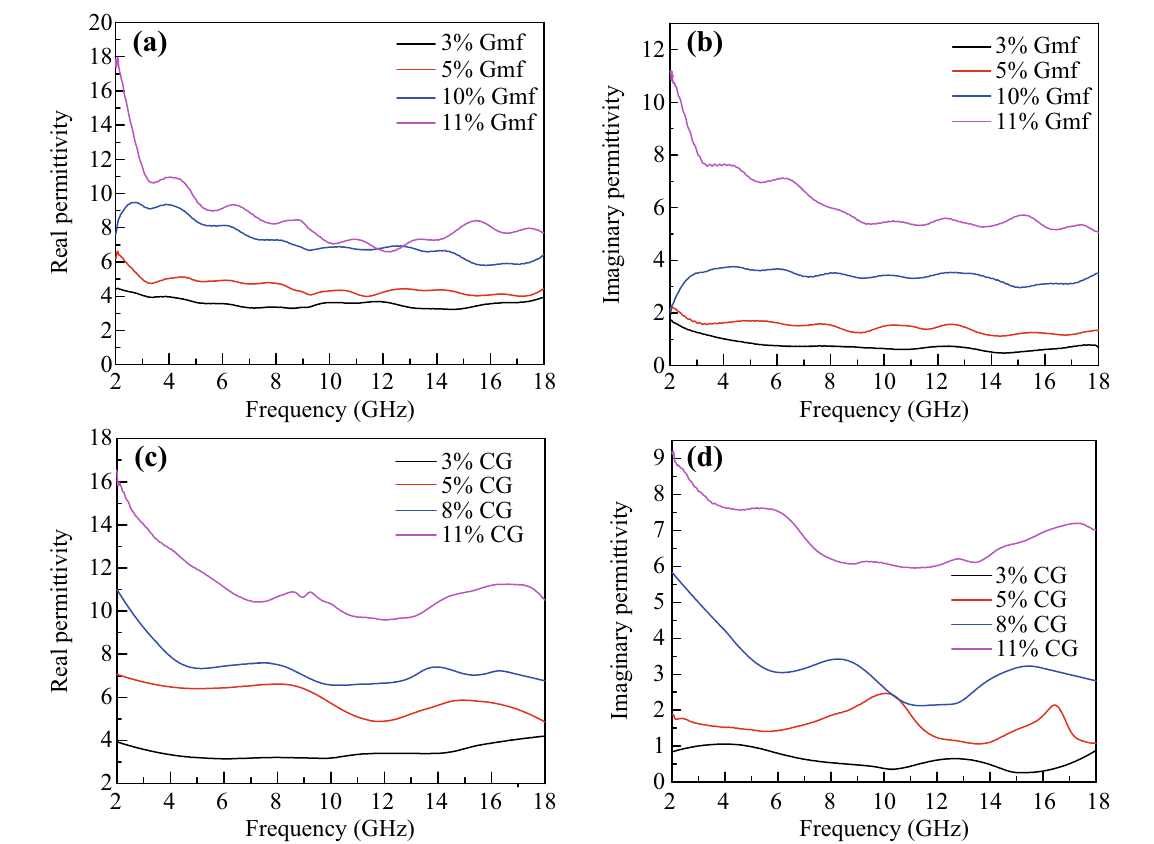
Fig. 3 a The real parts and b imaginary parts of permittivity of Gmfs/paraffin composites with different filler contents. c The real parts and d imaginary parts of permittivity of CG/paraffin composites with different filler